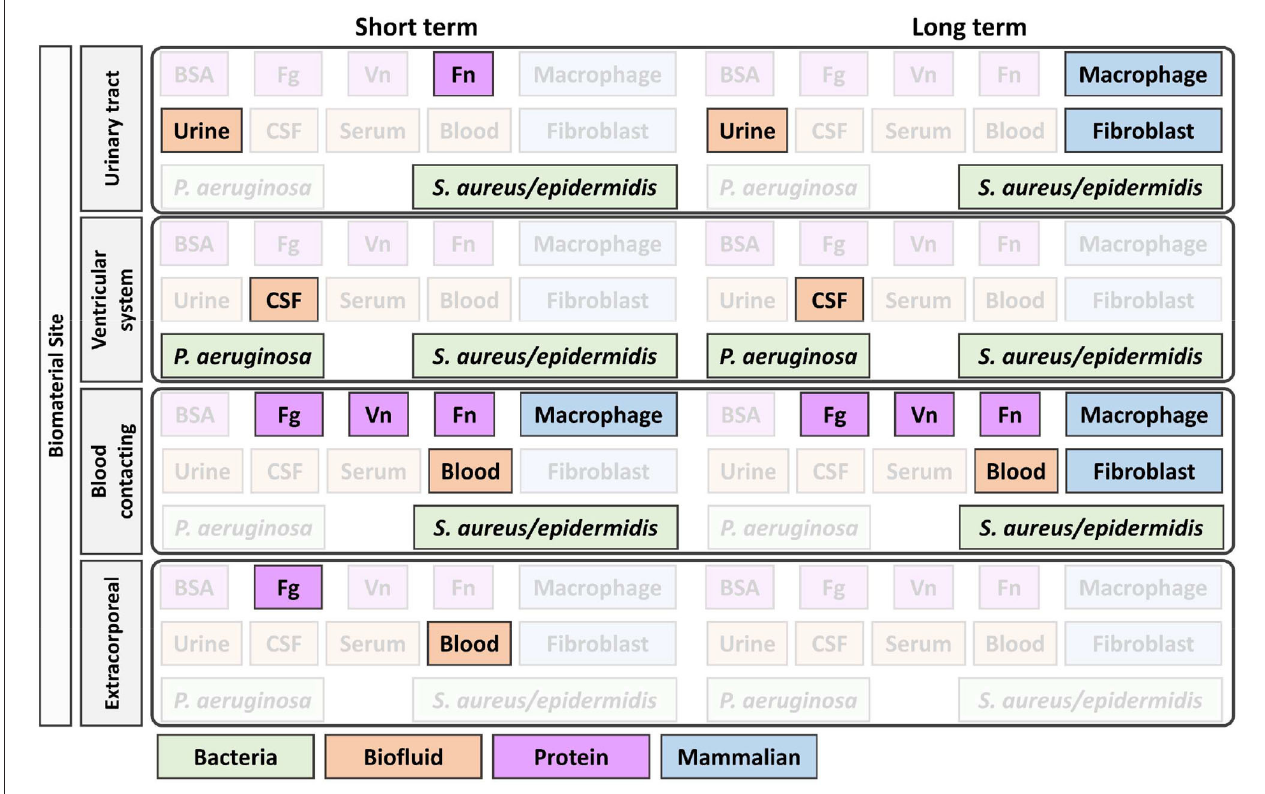
FIGURE 3 | Identification of appropriate in vitro biofouling experiments for low-fouling biomaterials. The site and length of implantation will determine the variety of biological components for screening. Above is an example of how the site and length of implantation can help guide the selection of biologic components for biofouling experiments. For experimental setup consideration of proteins and cells, refer to Figures 1 , 2 , respectively. BSA, bovine serum albumin; Fg, fibrinogen; Vn, vitronectin; Fn, fibronectin; P. aeruginosa , Pseudomonas aeruginosa ; S. aureus / epidermidis , Staphylococcus aureus/Staphylococcus epidermidis .